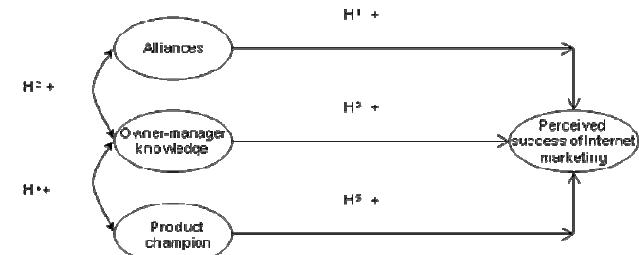
Figure 1: The theoretical model Table 2: Definition of measurement